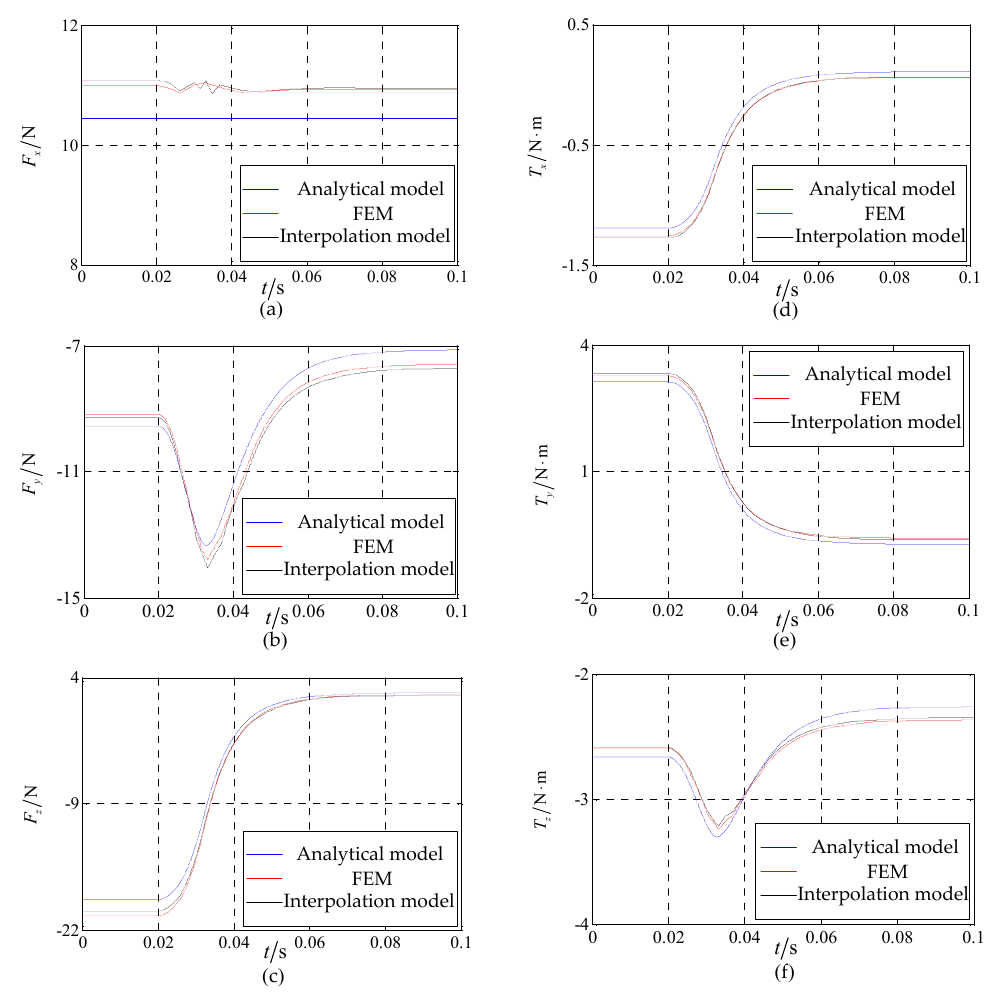
Figure 13. Forces /torques of a coil in FEM, analytical method and interpolation method.